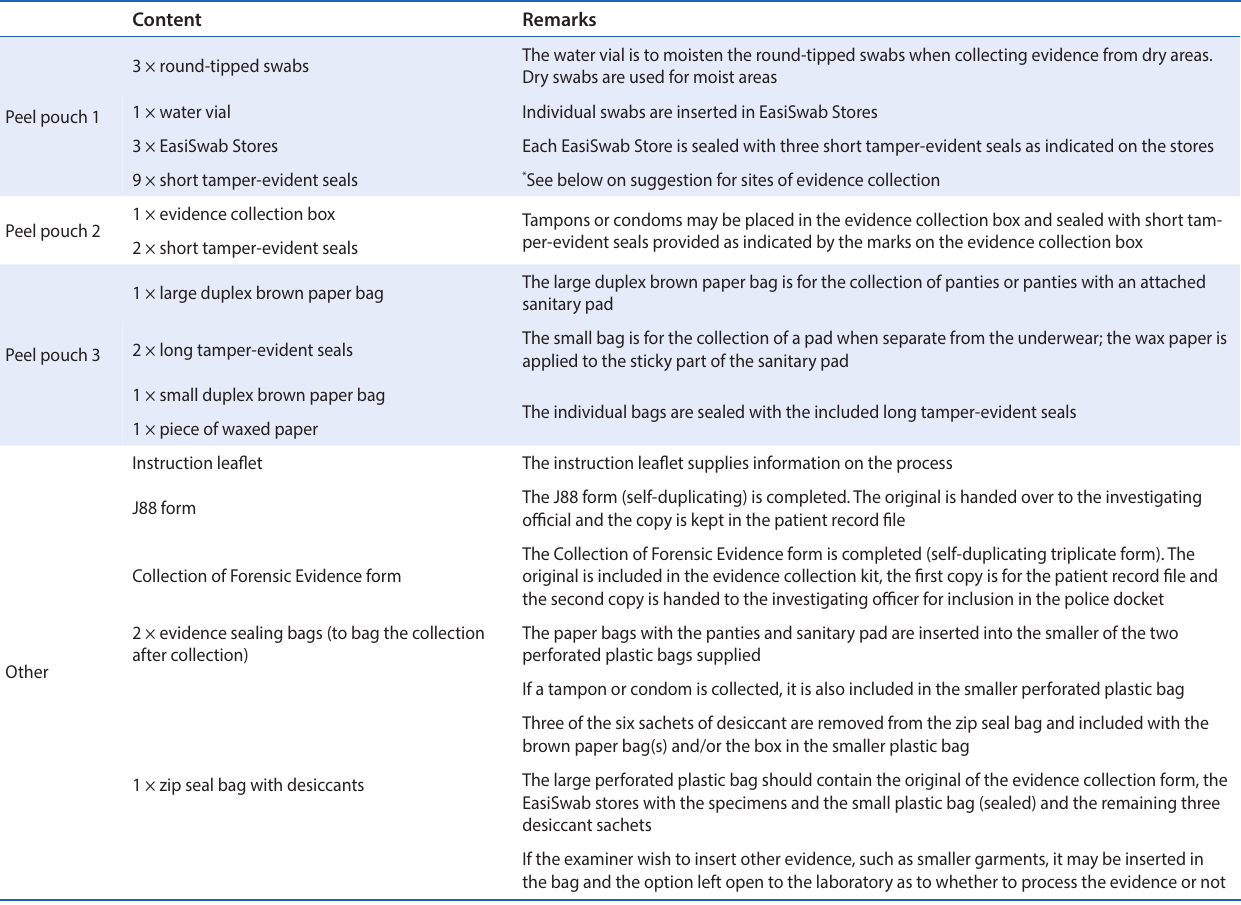
Table 1: D1 Adult Sexual Assault Evidence Collection Kit